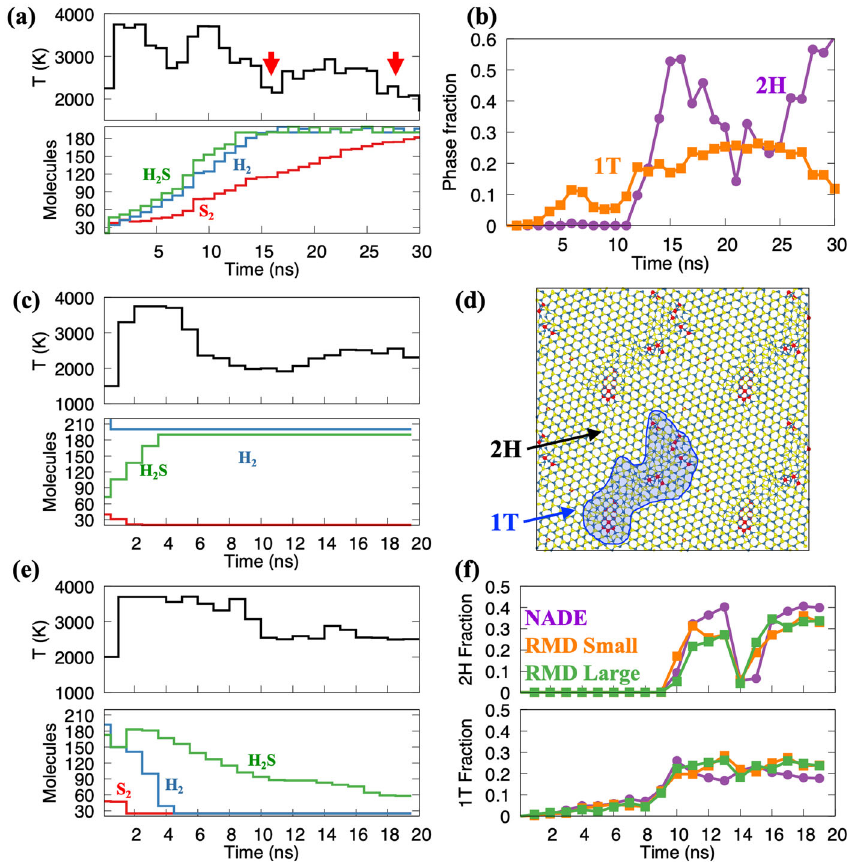
Fig. 5 Extensions of RL + NADE-CVD Method. a , b A 30-ns long synthesis pro fi le predicted by RL + NADE-CVD retains design principles about two-phase temperature cycle and low initial gas phase concentrations learned from 20-ns RMD trajectories. In addition, the 30-ns pro fi le also includes a temperature annealing step between 15 – 30 ns (arrows) that improves the 2H phase fraction beyond 60%. c RL + NADE- CVD generated synthesis schedule for optimizing 1T phase fraction. d Output structure from an RMD simulation of the 1T-optimized synthesis schedule reveals a heterostructure containing a 1T-rich region embedded in the 2H phase. e , f The robustness of RL-generated pro fi les against system size-scaling is validated by the identical fractions of 2H and 1T phases in laterally-small and laterally-large systems simulated using RMD using the same pro fi